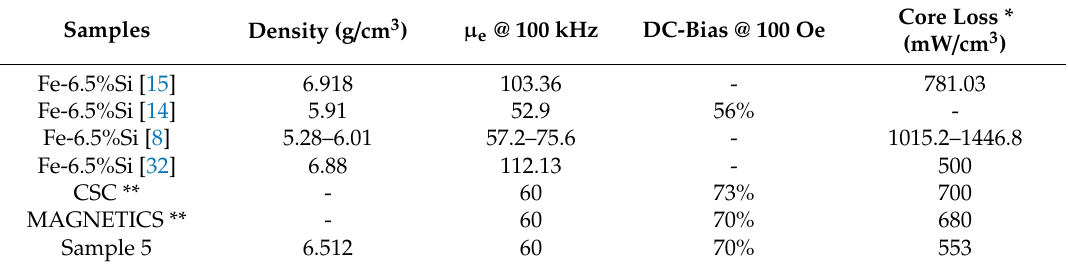
Figure 7. The quality factor as a function of the frequency for samples 1–5. Table 1. Comparison of Fe-6.5 wt%Si soft magnetic powder cores (SMPCs) performance of literature reported previously, products of some companies and this